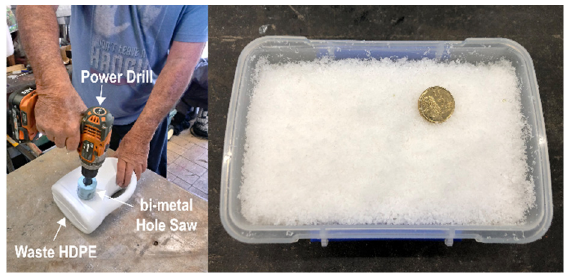
Figure 2. Sample Preparation (Image Courtesy: Benjamin Piromanski).